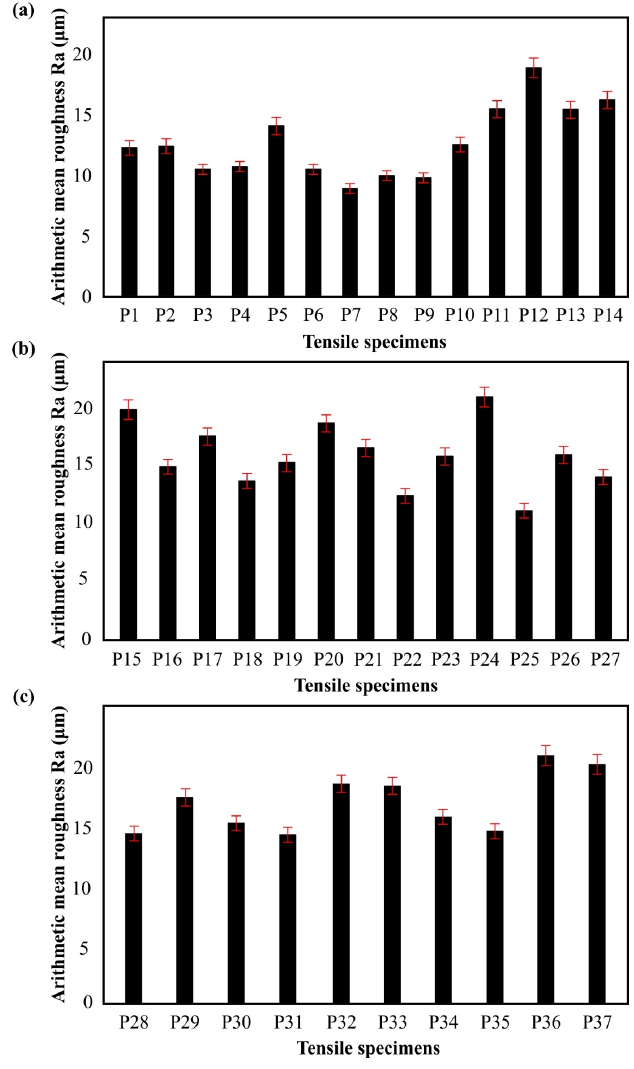
Figure 5. Experimental results for the arithmetic mean roughness Ra of the samples’s top surface measured at y-axis: ( a ) P1-P14, ( b ) P15-P27, and ( c ) P28-P37.